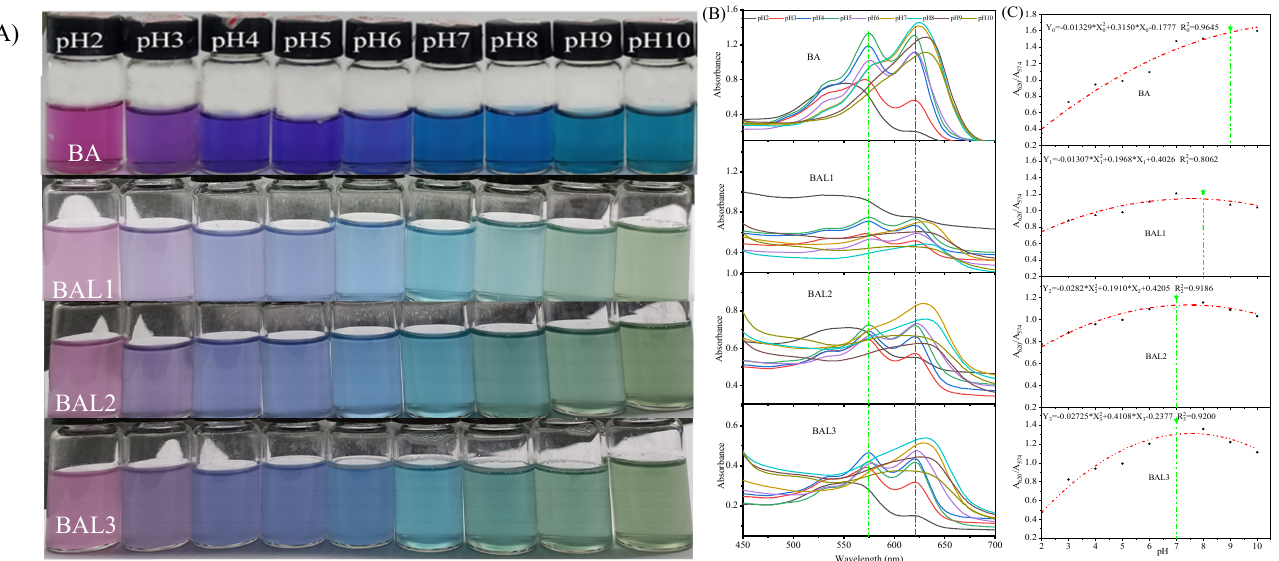
Figure 1. Color ( A ) and ultraviolet-visible spectra ( B ), and the ratio of A 620 and A 574 ( C ) of BA and BAL at different pH values.